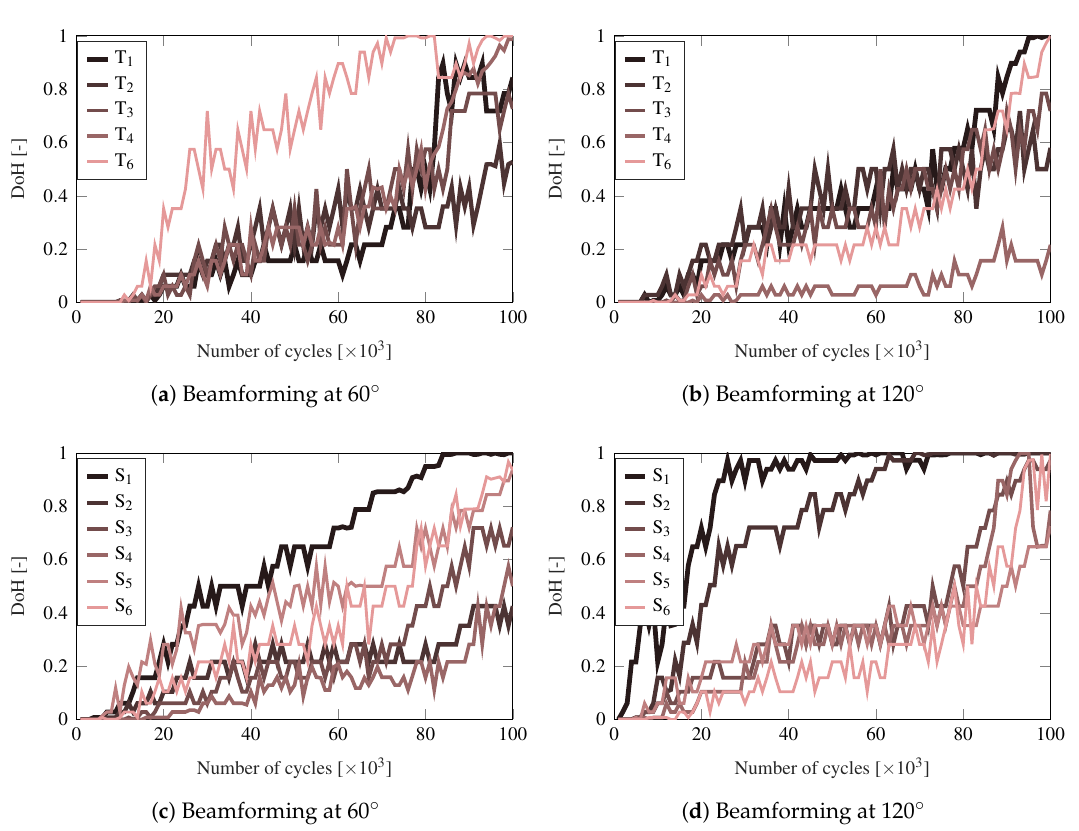
Figure 7. Evolution of the mean value of all DoH matrices obtained throughout the fatigue test in comparison with the crack length of the aluminum specimen in panel ( a ). Panel ( b ) shows the fatigue crack at 100,000 cycles along with the points used to digitize its length.